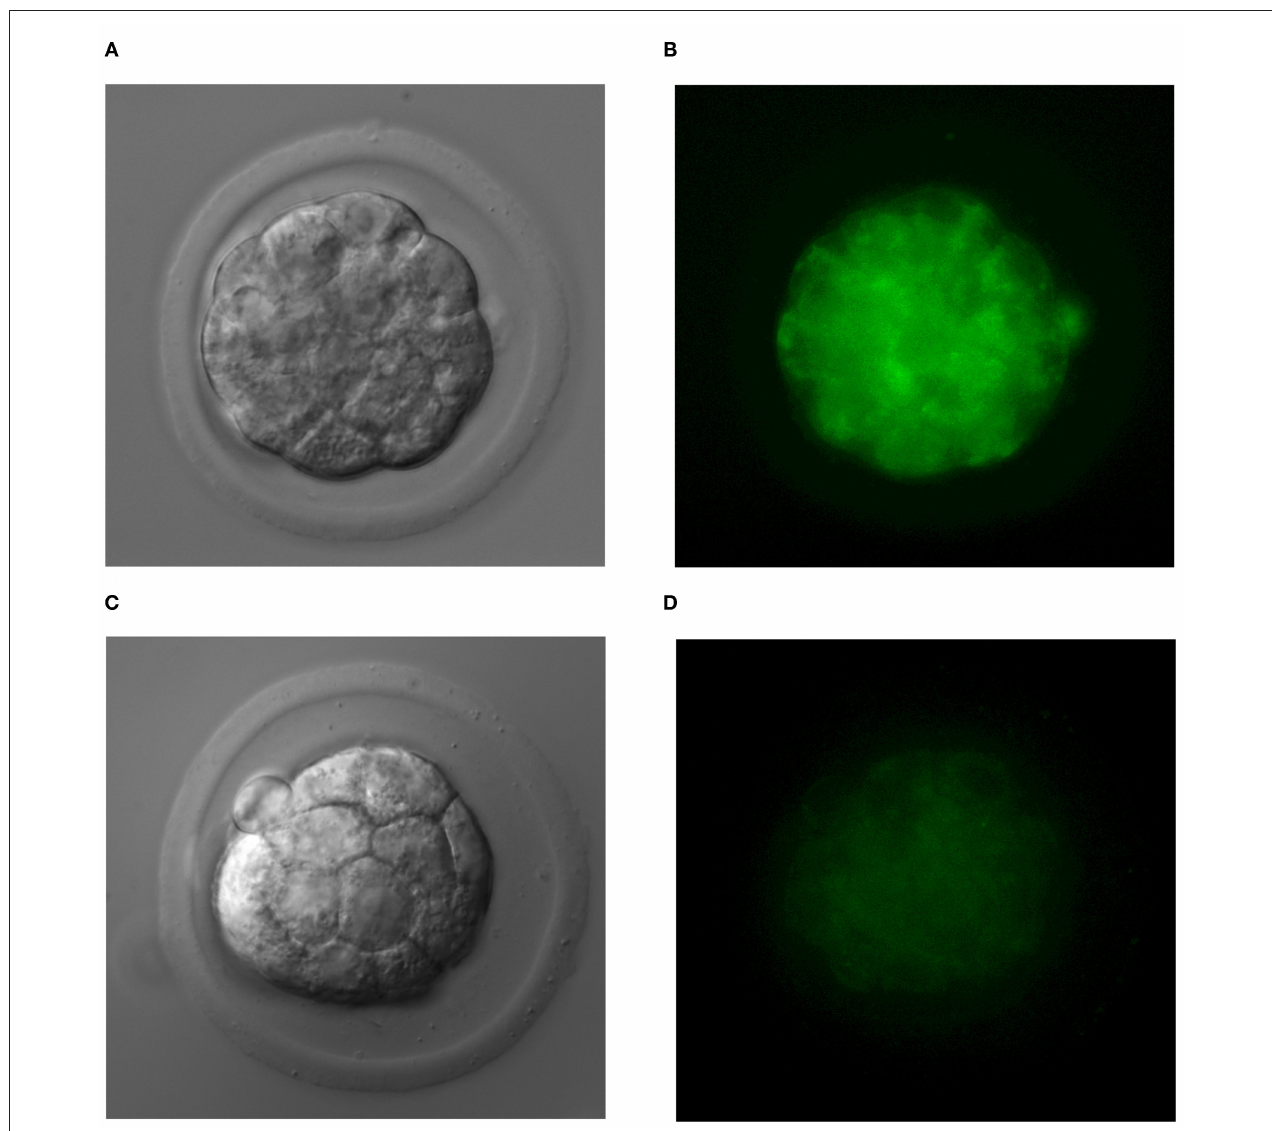
FIGURE 2 | The uniform pattern of phosphatidylserine expression in blastomeres of TNF α -treated embryos (A,B) and normal embryos (C,D)